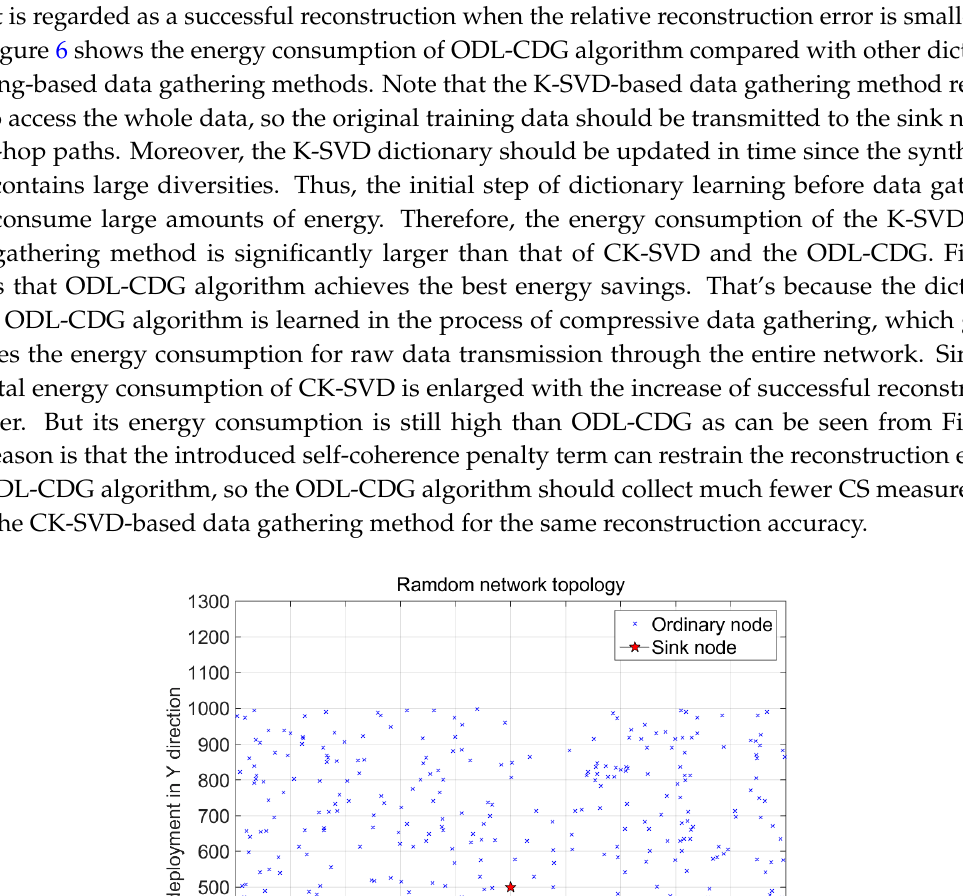
Table 2. Experimental parameters.